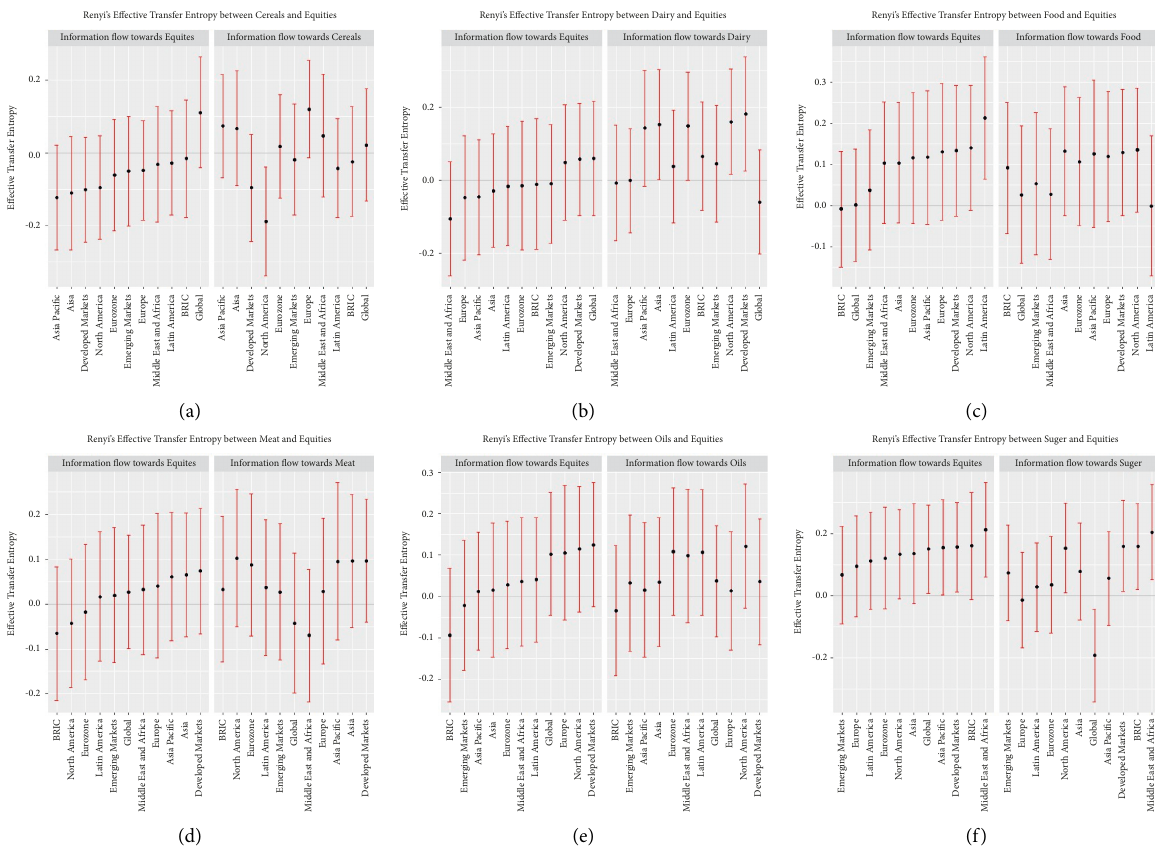
Figure 3: Transfer entropies at the composite level. Notes: This figure presents the quantified information flow between the returns on world food commodity and regional equity markets for the signal/composite data. (a) to (f), respectively, represent ETEs for cereals, dairy, food, meat, vegetable oil, and sugar indices against the regional